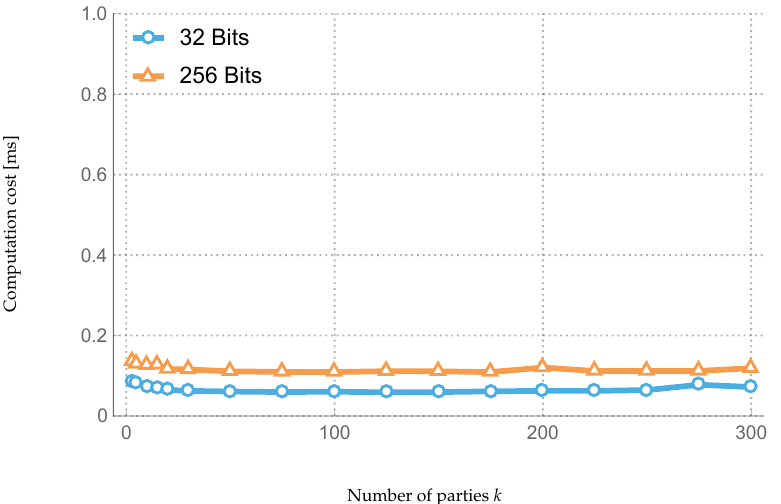
Figure 7. Rate transaction computation cost.